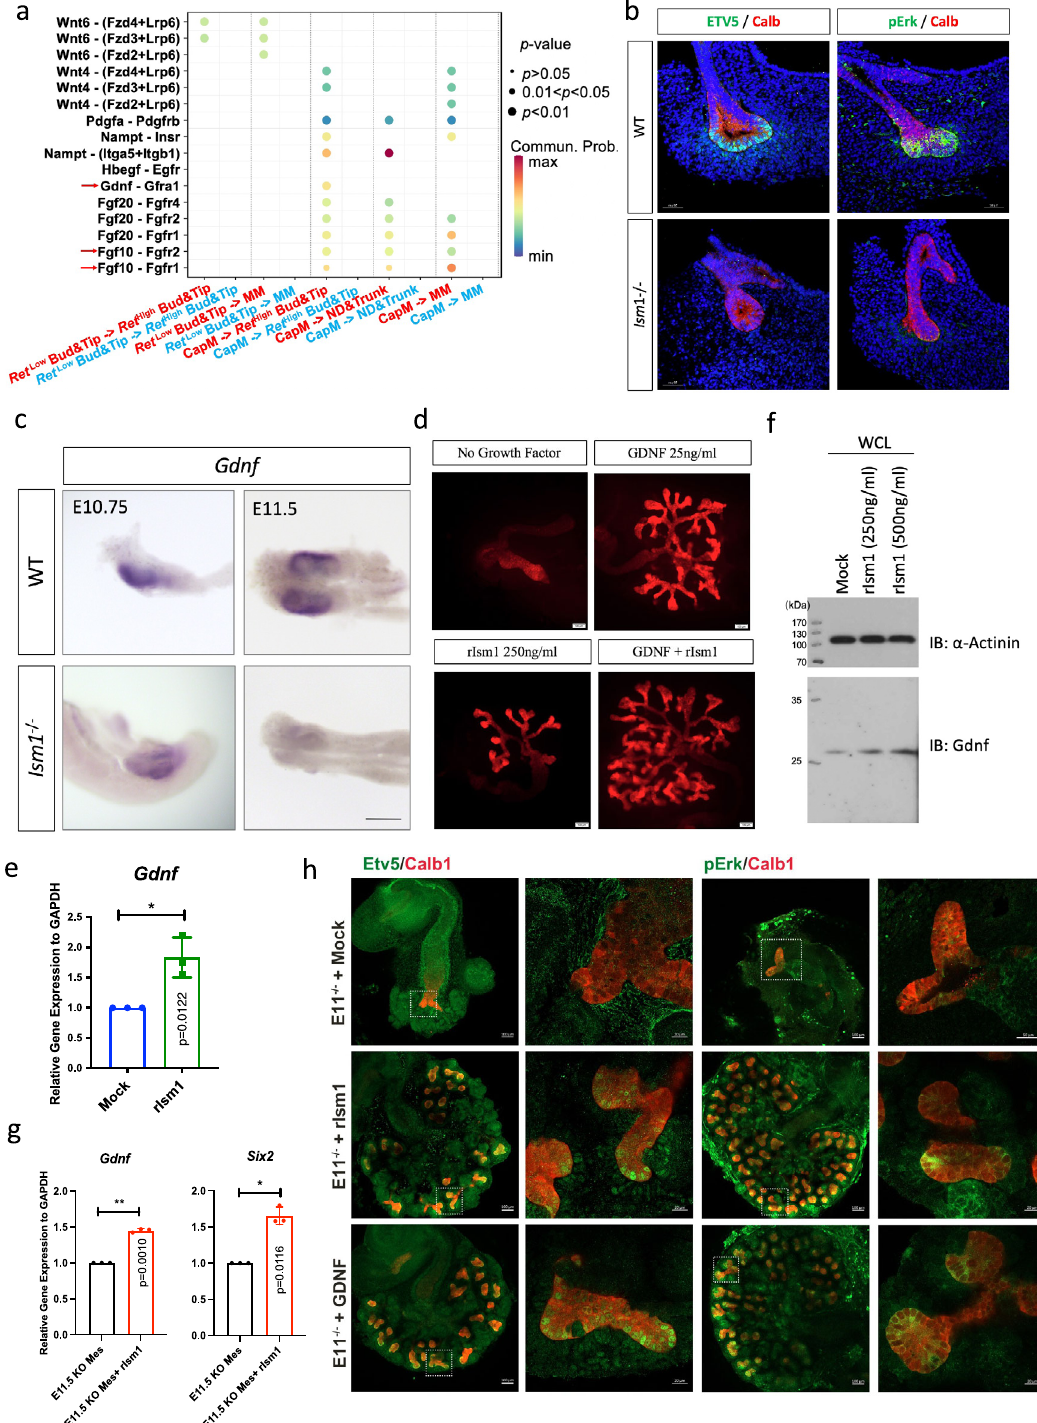
Fig. 5 | Attenuated Gdnf/Ret signaling in Ism1 − / − mice. a Comparison of crosstalk between UE and NPC lineage in WT and Ism1 − / − kidney rudiments. Dot color representscommunicationprobabilitiesanddotsizerepresentscomputed p -value. Empty space indicates that the communication probability is zero. p -values are computedfrom one-sidedpermutation test. b E11.5 kidney sections from WT (top) and Ism1 − / − mice (bottom) were immunostained with Calb1 (Red) and Etv5 (Green) orpErk(Green).Scalebars,50 µ m. c Insituhybridizationof Gdnf inE10.75andE11.5 kidney rudiments from Ism1 − / − and WT mice. Scale bar, 200 μ m. d Calbindin1 staining of Kidney rudiments explants from E11.5 Ism1 − / − embryos cultured for 72h in the presence or absence of Gdnf (25ng/ml) and rIsm1 (250ng/